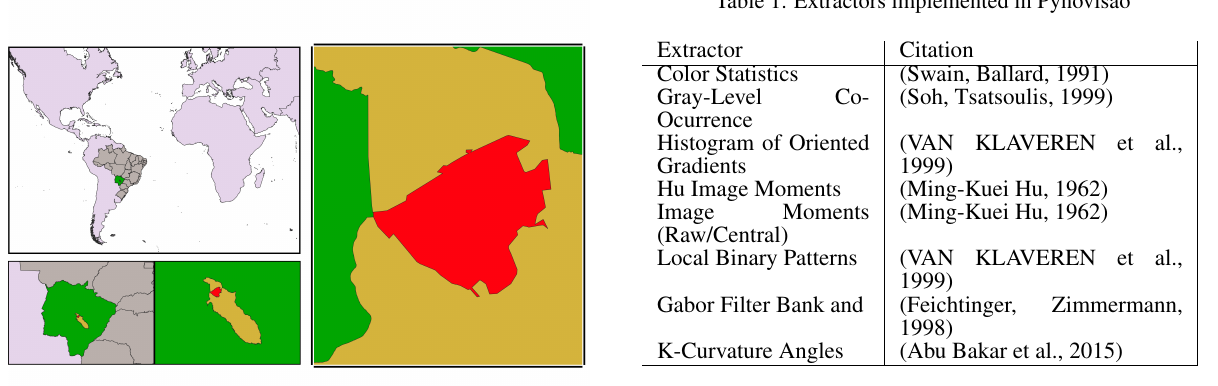
Table 1. Extractors implemented in Pynovis˜ao